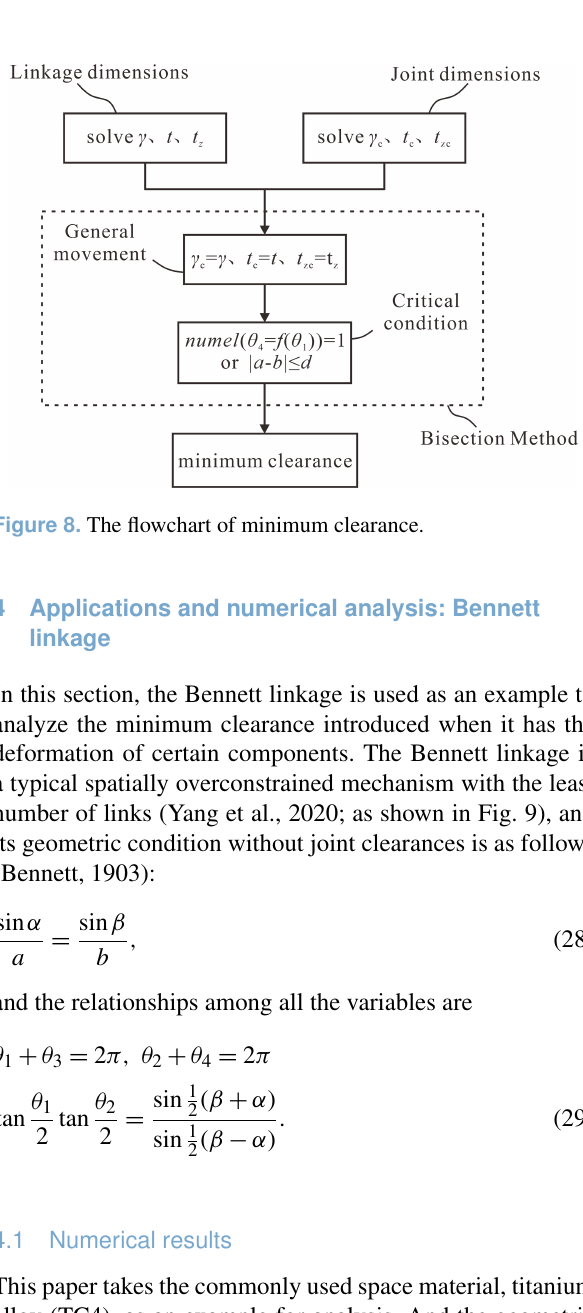
Figure 7. Linkages are separated into the (a) input part and (b) output part.